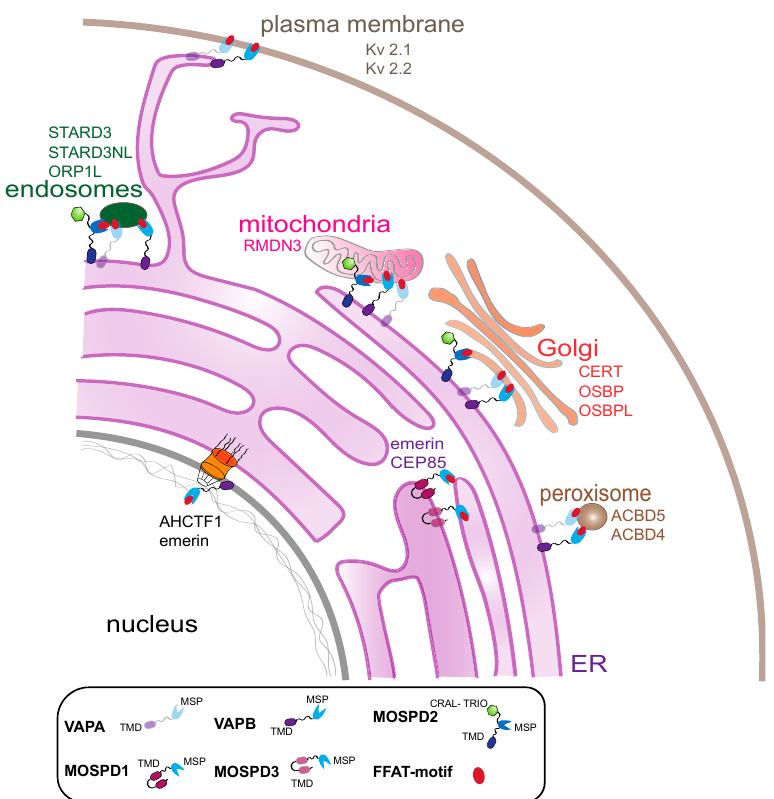
Figure 6. Proteins of the VAP family connect the ER and other organelles. Schematic representation of the interaction of all the family members with FFAT-motif at MCSs of the ER and endosomes, mitochondria, the plasma membrane, the Golgi apparatus, peroxisomes and the nuclear envelope. VAP proteins and a few examples of interacting proteins (FFAT-motif containing proteins) at the MCSs are depicted close to the organelles.